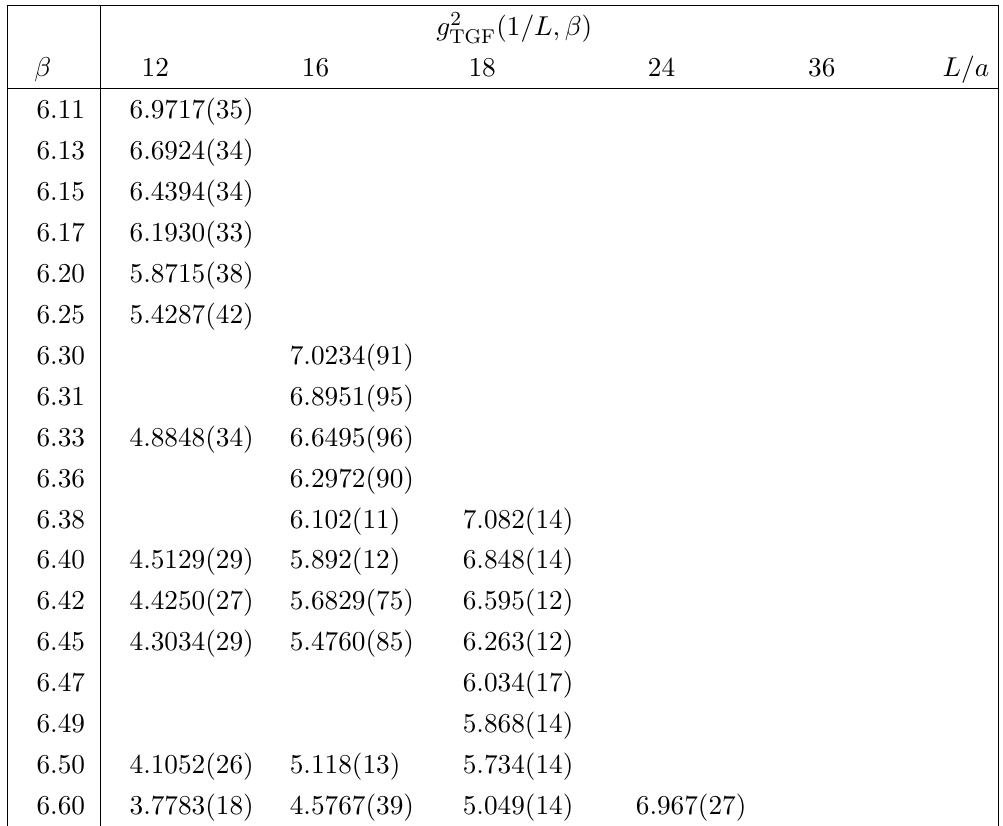
Table 1 . TGF coupling on each L=a and (cid:12)